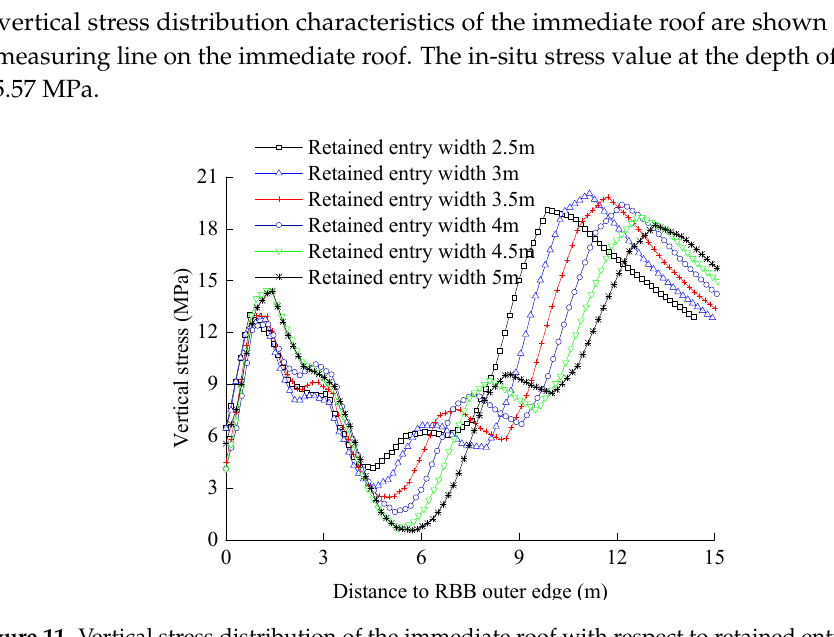
Figure 11. Vertical stress distribution of the immediate roof with respect to retained entry width.